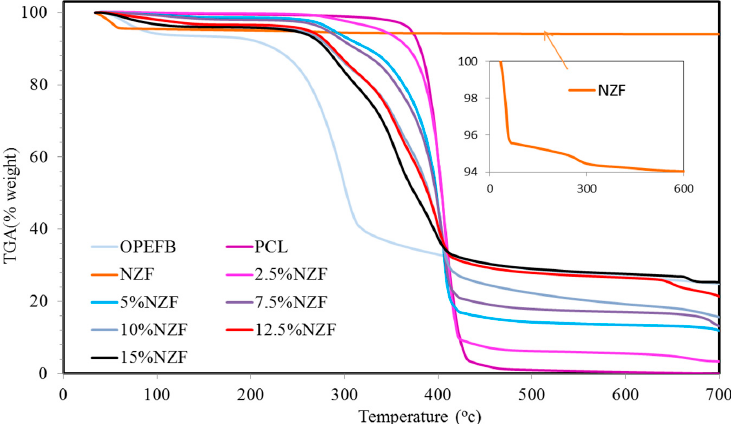
Figure 3. TGA thermograms of OPEFB fibres, NZF, PCL and NZF + OPEFB + PCL for different percentages of NZF filler in the composites.